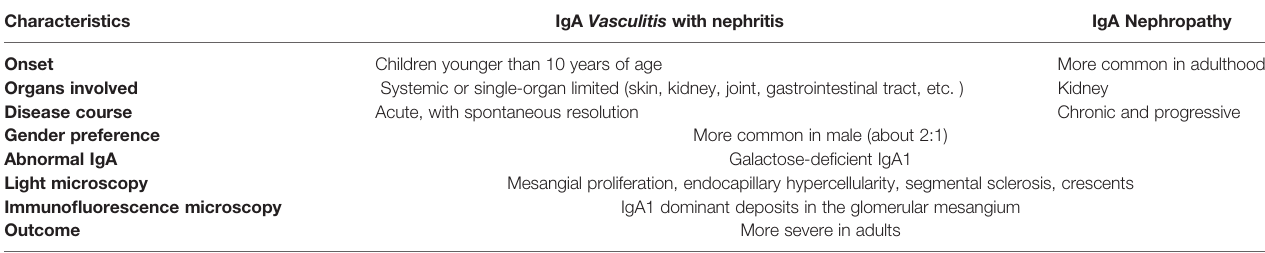
TABLE 1 | Differences and similarities between IgAV with nephritis and IgAN(48, 49).